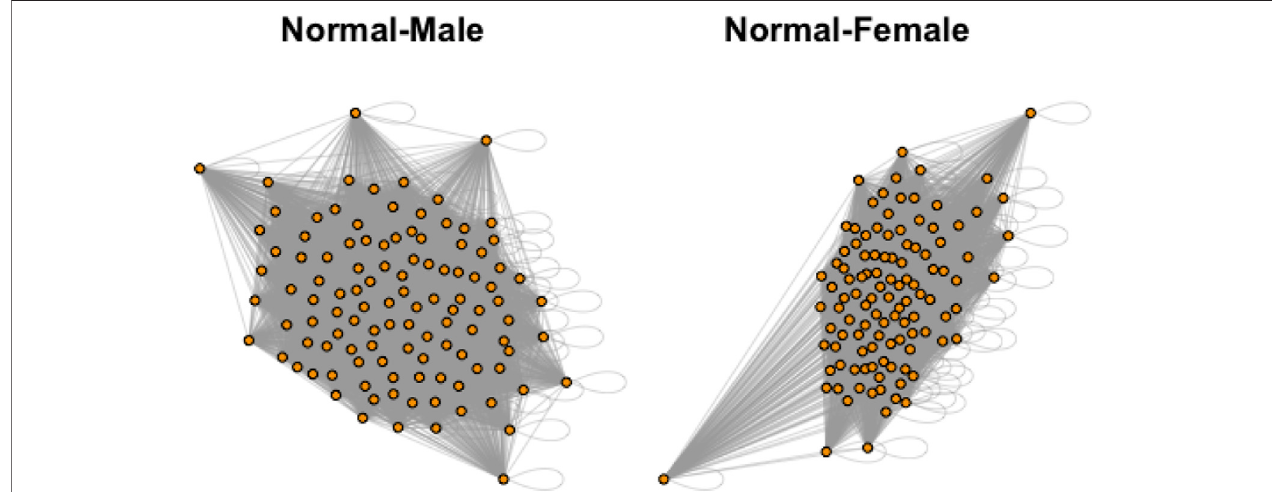
FIGURE 3 | Example networks from Normal-Male and Normal-Female